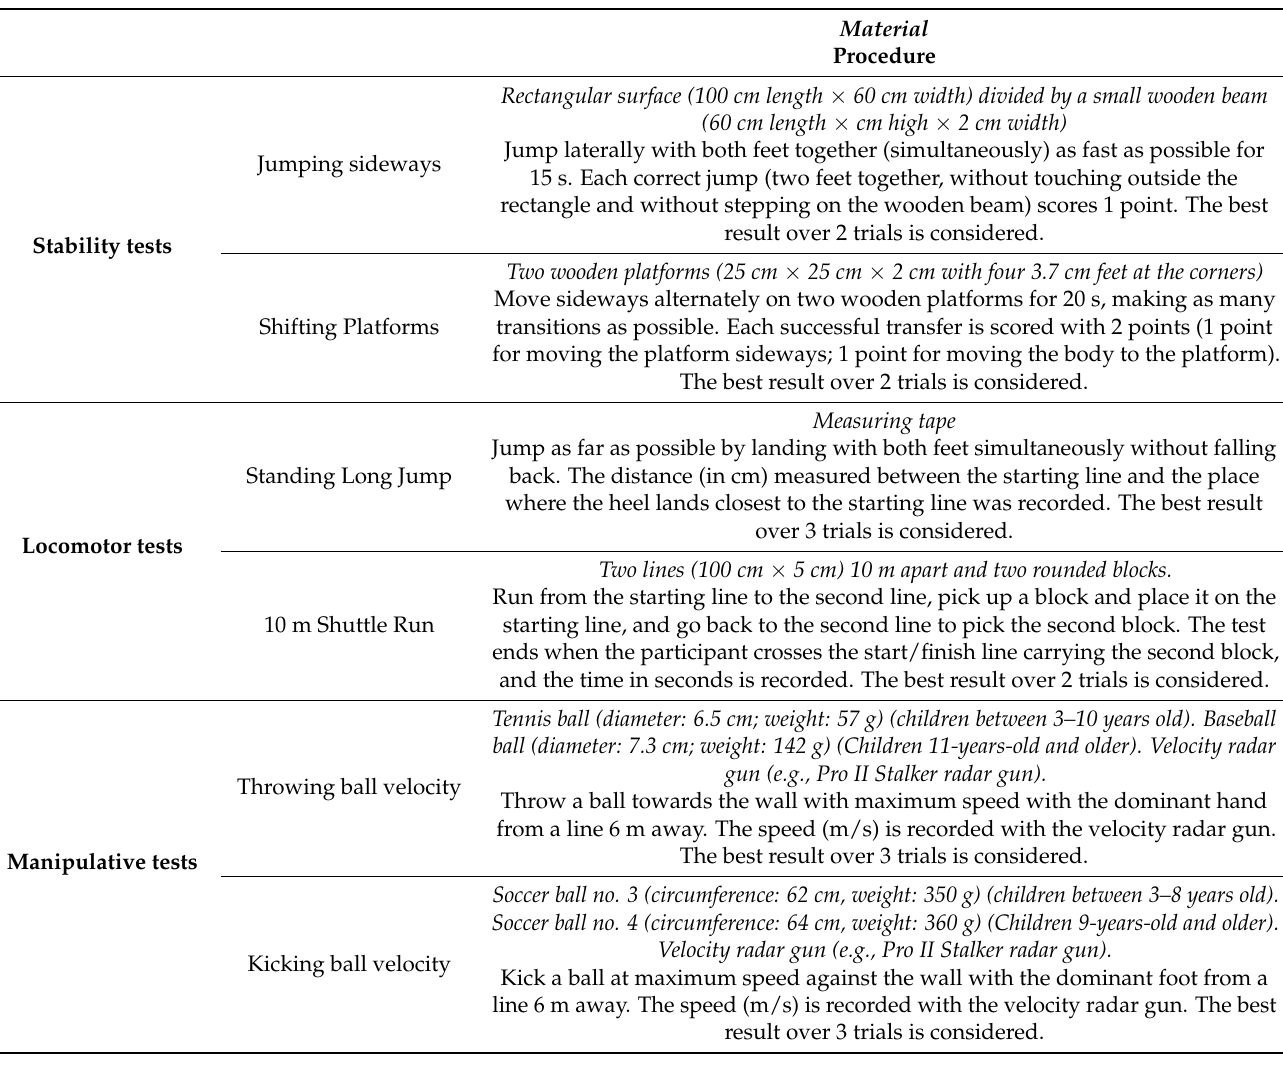
Table 1. Tests included in the Motor Competence